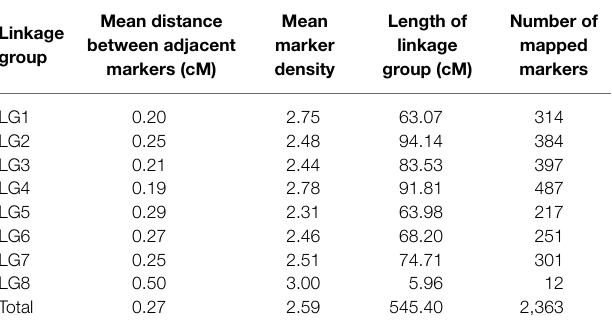
TABLE 1 | Marker distribution over the linkage groups of the linkage map derived from a cross between ILWL 180 and ILL 6002. Mean distance Linkage between adjacent group markers